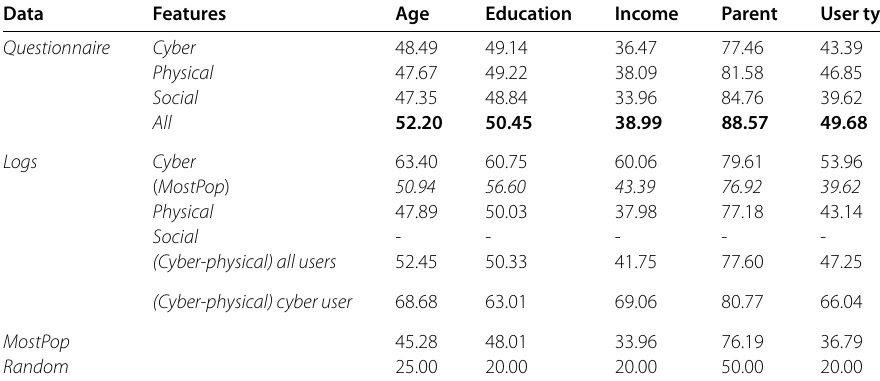
Table 8 Accuracy of demographic prediction from questionnaire and logs Data